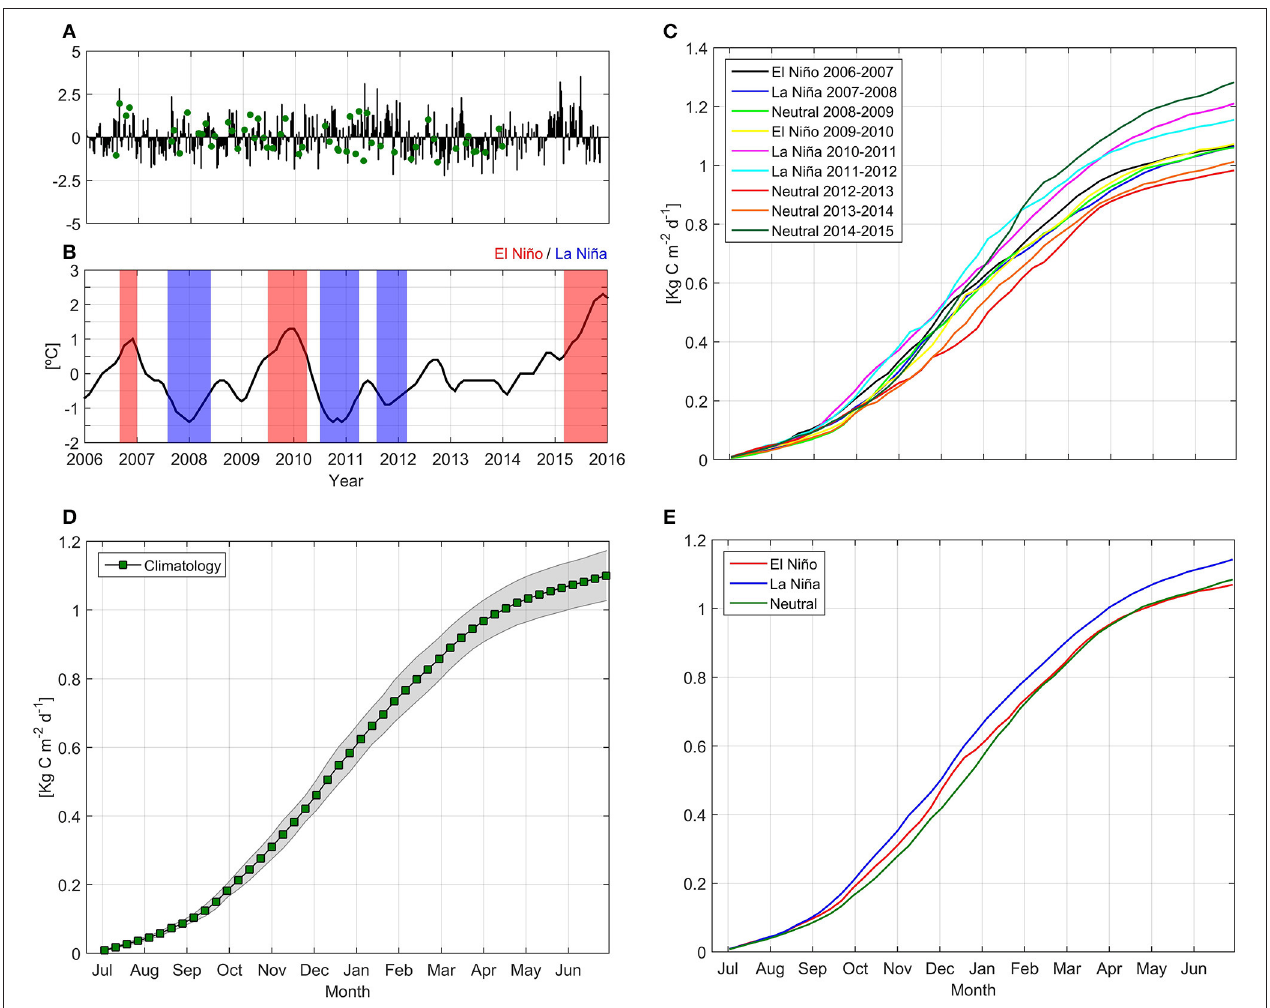
FIGURE 7 | Temporal evolution of standardized anomaly for in situ and satellite Net Primary Production (NPP, A ), temporal evolution of the Oceanic Niño Index (B) and cumulative satellite NPP estimations by year (C) , climatological NPP mean with 95% confidence interval (markers and shaded area, respectively, D ) and mean satellite-derived NPP values during El Niño, La Niña, and Neutral conditions (E) . Green points in NPP time series panel indicate in situ